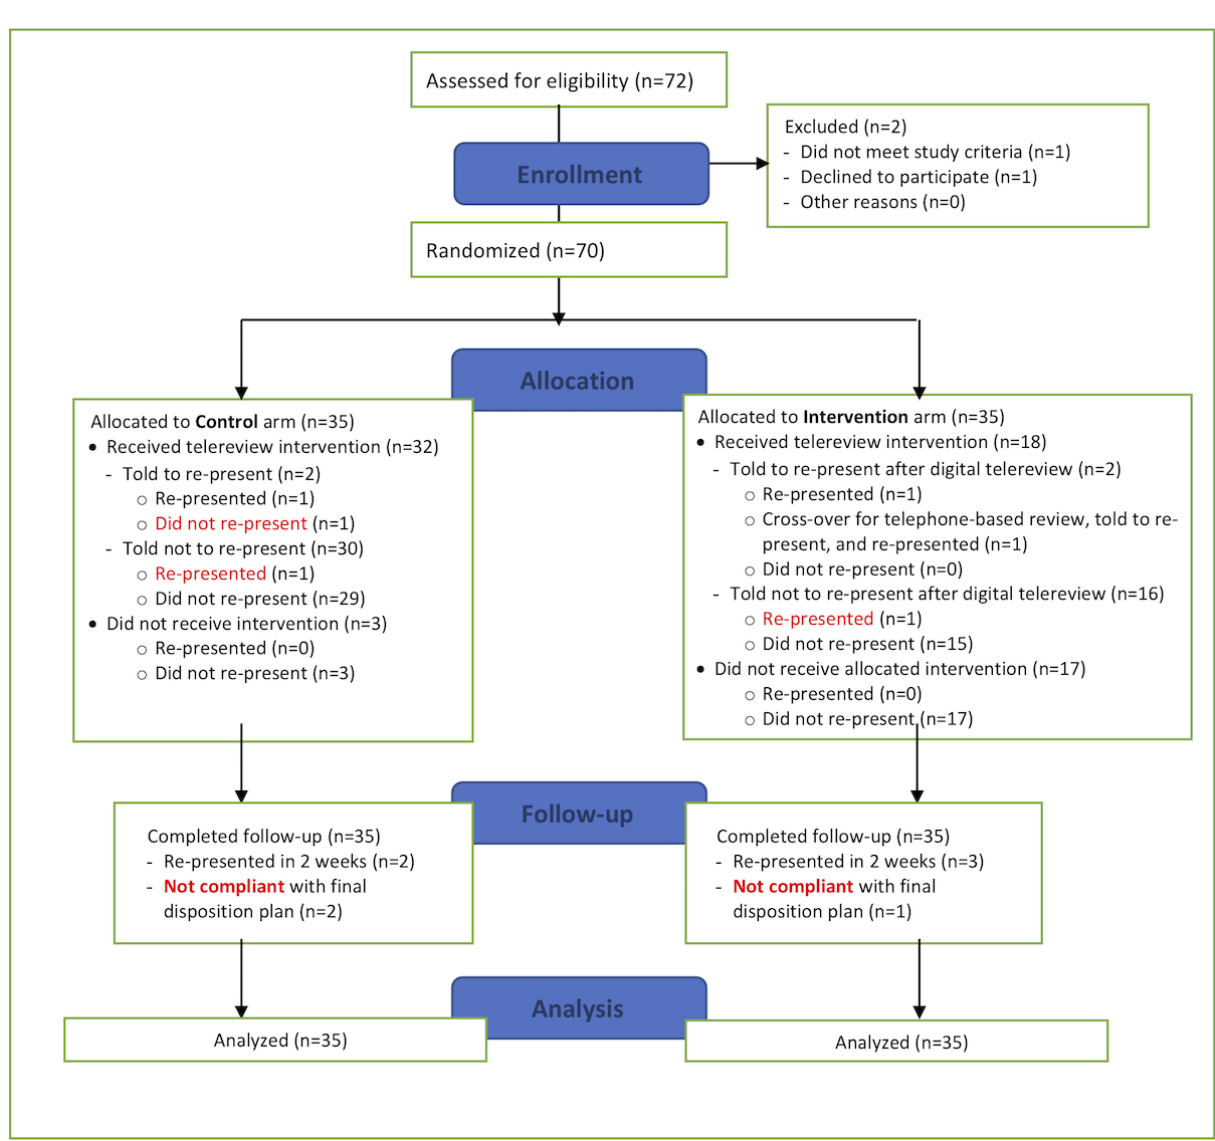
Figure 1. A CONSORT diagram depicting the study. Patients in the control arm receive the push-to-patient form of telephone telereview while patients in the intervention arm receive the pull-from-patient form of digital